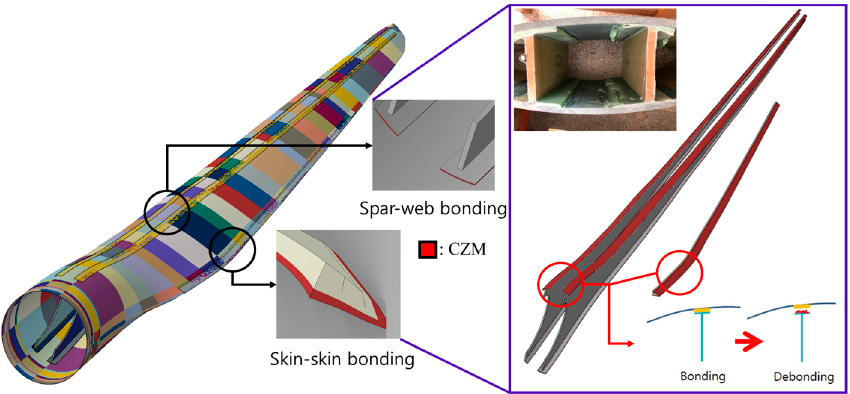
Figure 5. Schematic of the research objectives.